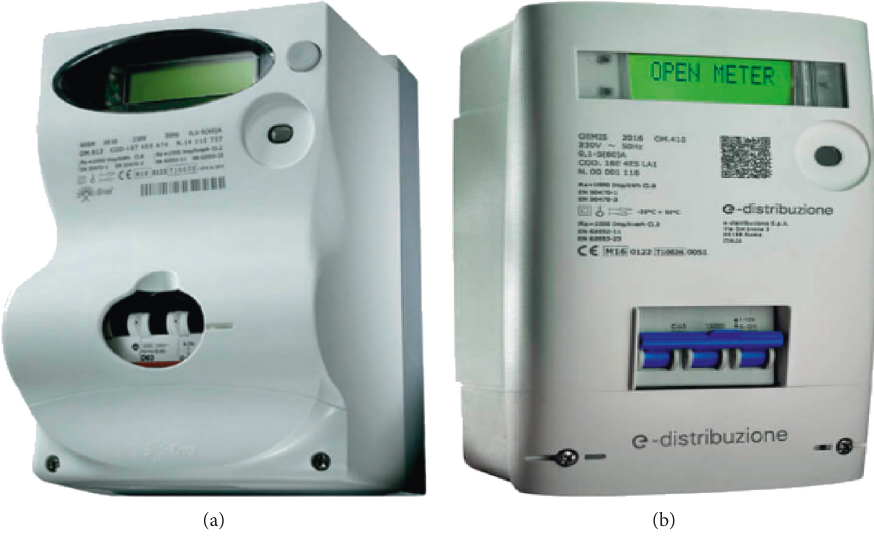
Figure 2: Electrical energy meter 1G (a) and open energy meter 2G